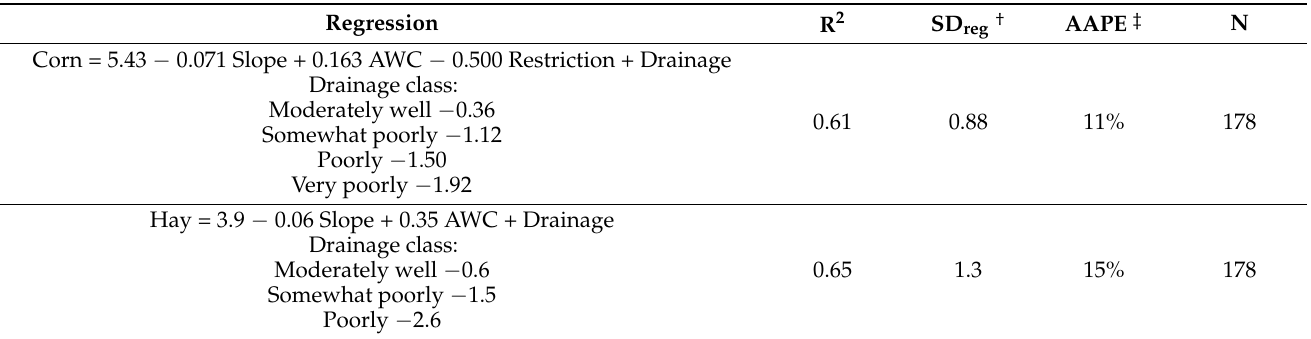
Table 6. Pooled regressions of expected corn and hay yields (MT · ha − 1 ) vs. the soil physical character- istics of average percent slope (Slope), plant available water holding capacity (cm) in the top 100 cm of the soil (AWC), and the presence or absence (1 vs. 0) of a restriction layer in the soil, and the soil’s drainage class.